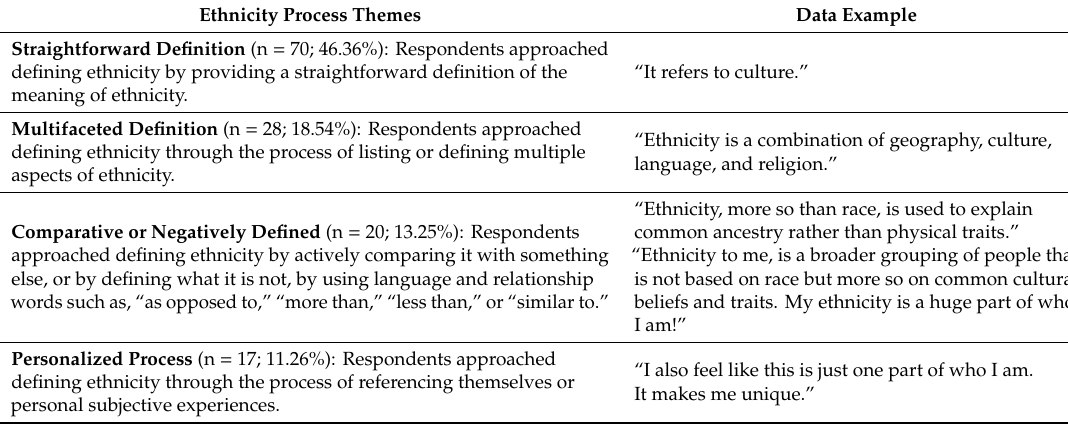
Table 3. Participants’ process approaches to generating meanings of